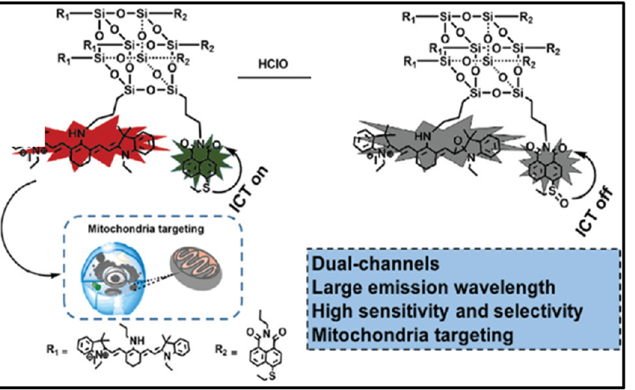
Figure 22. Schematic illustration of the sensing mechanism of POSS-Cy7-N toward ClO¯ [103].